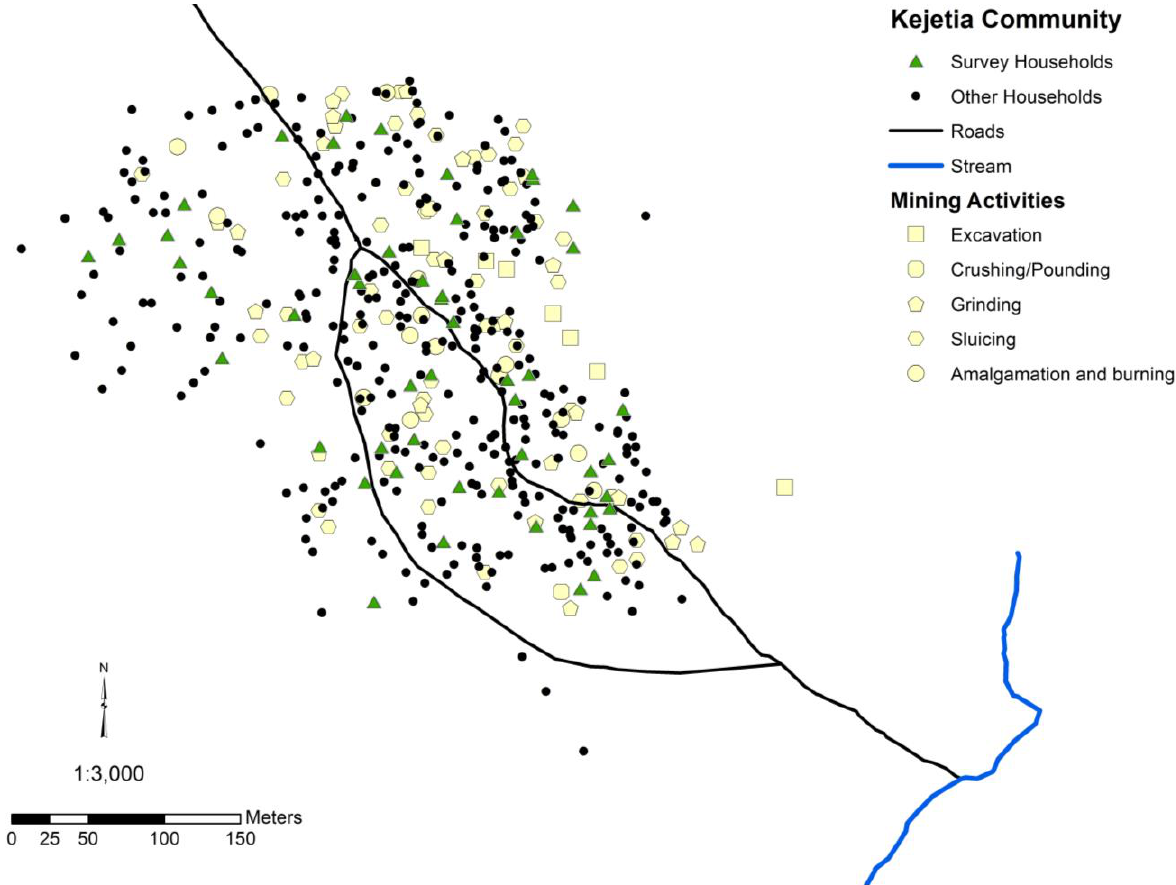
Figure 2. Map of the Kejetia community, indicating households surveyed, community markers, and locations of mining